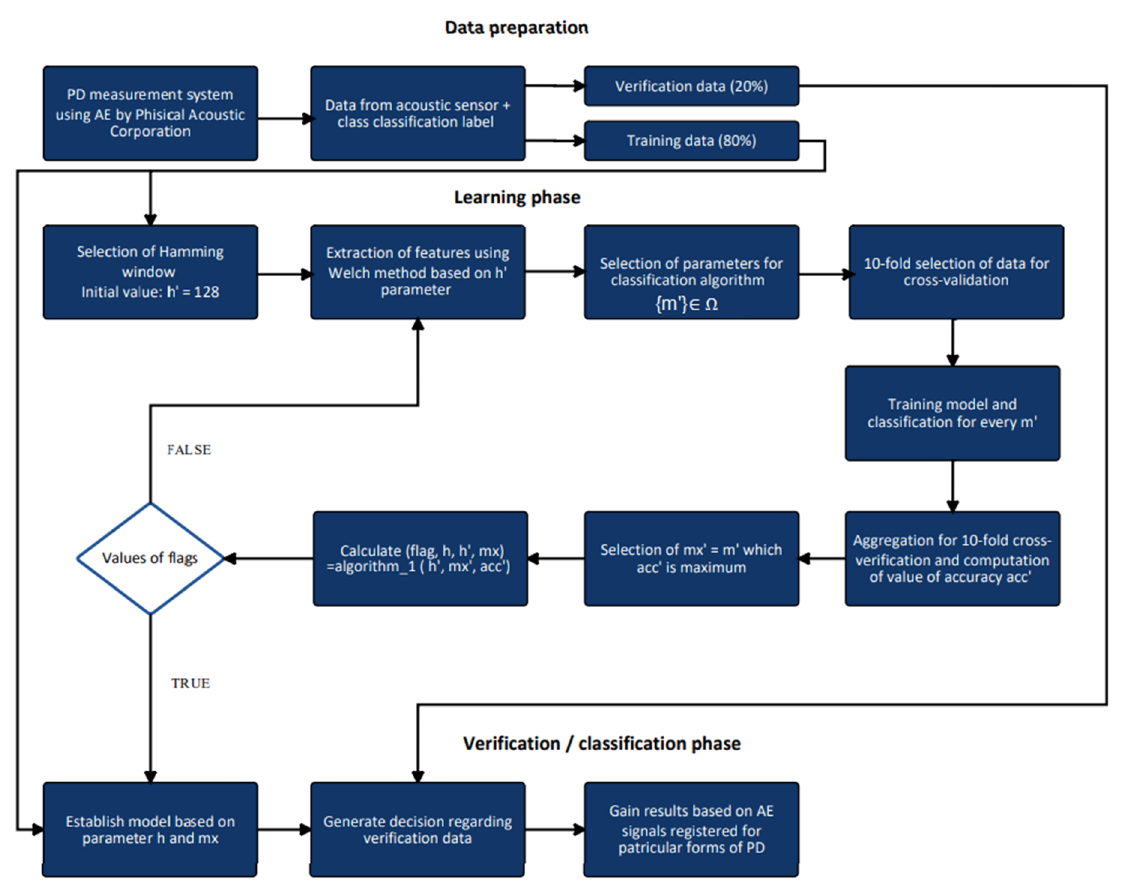
Figure 4. Block diagram of proposed algorithm applied for classification of AE signals depending on PD forms.